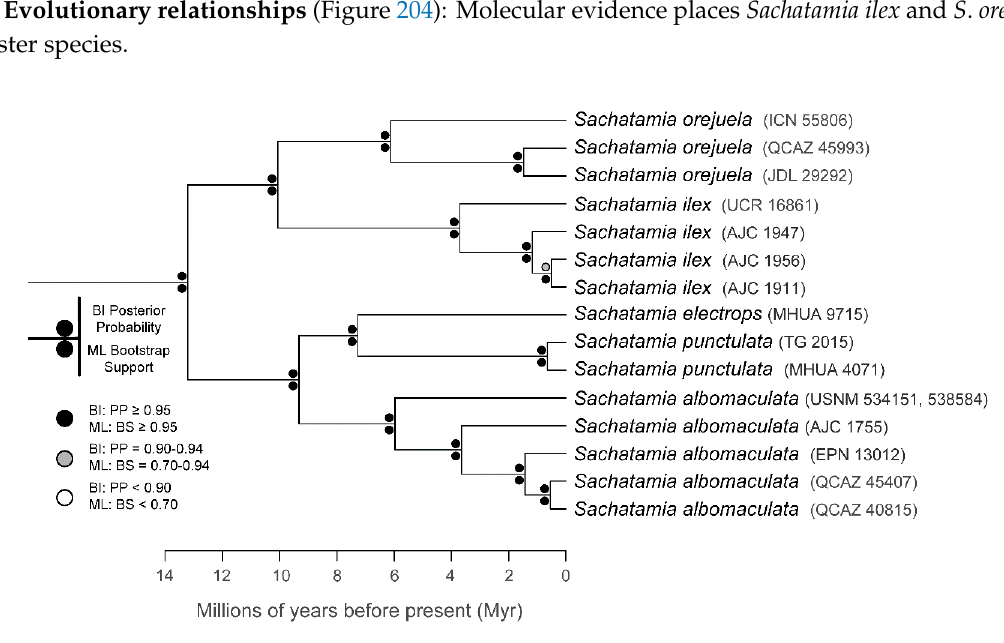
Figure 203. Distribution of Sachatamia ilex in Ecuador (yellow dots).